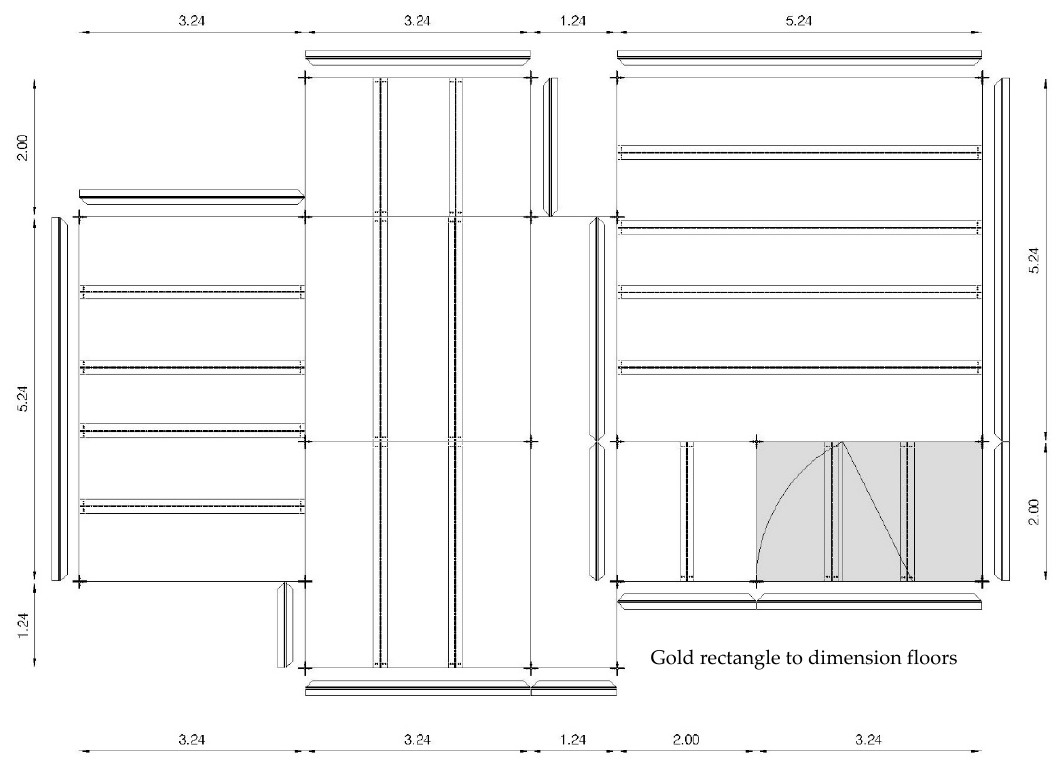
Figure 7. Organization of pavement areas and their connection with columns and girders with Greek cross shape/secondary beams with T-shape—plan view.